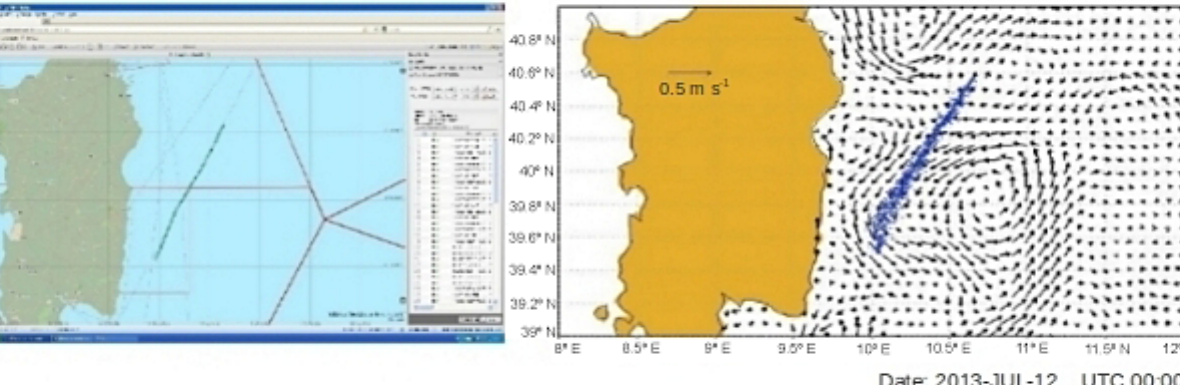
Figure 2. The last known position, represented by the blue particles’ distribution at the alert time; it is based on the automatic information system (AIS) that gives the ferry position every 6s (green line on the left of the picture). The coordinates of the start and end point are defined in Table 1.